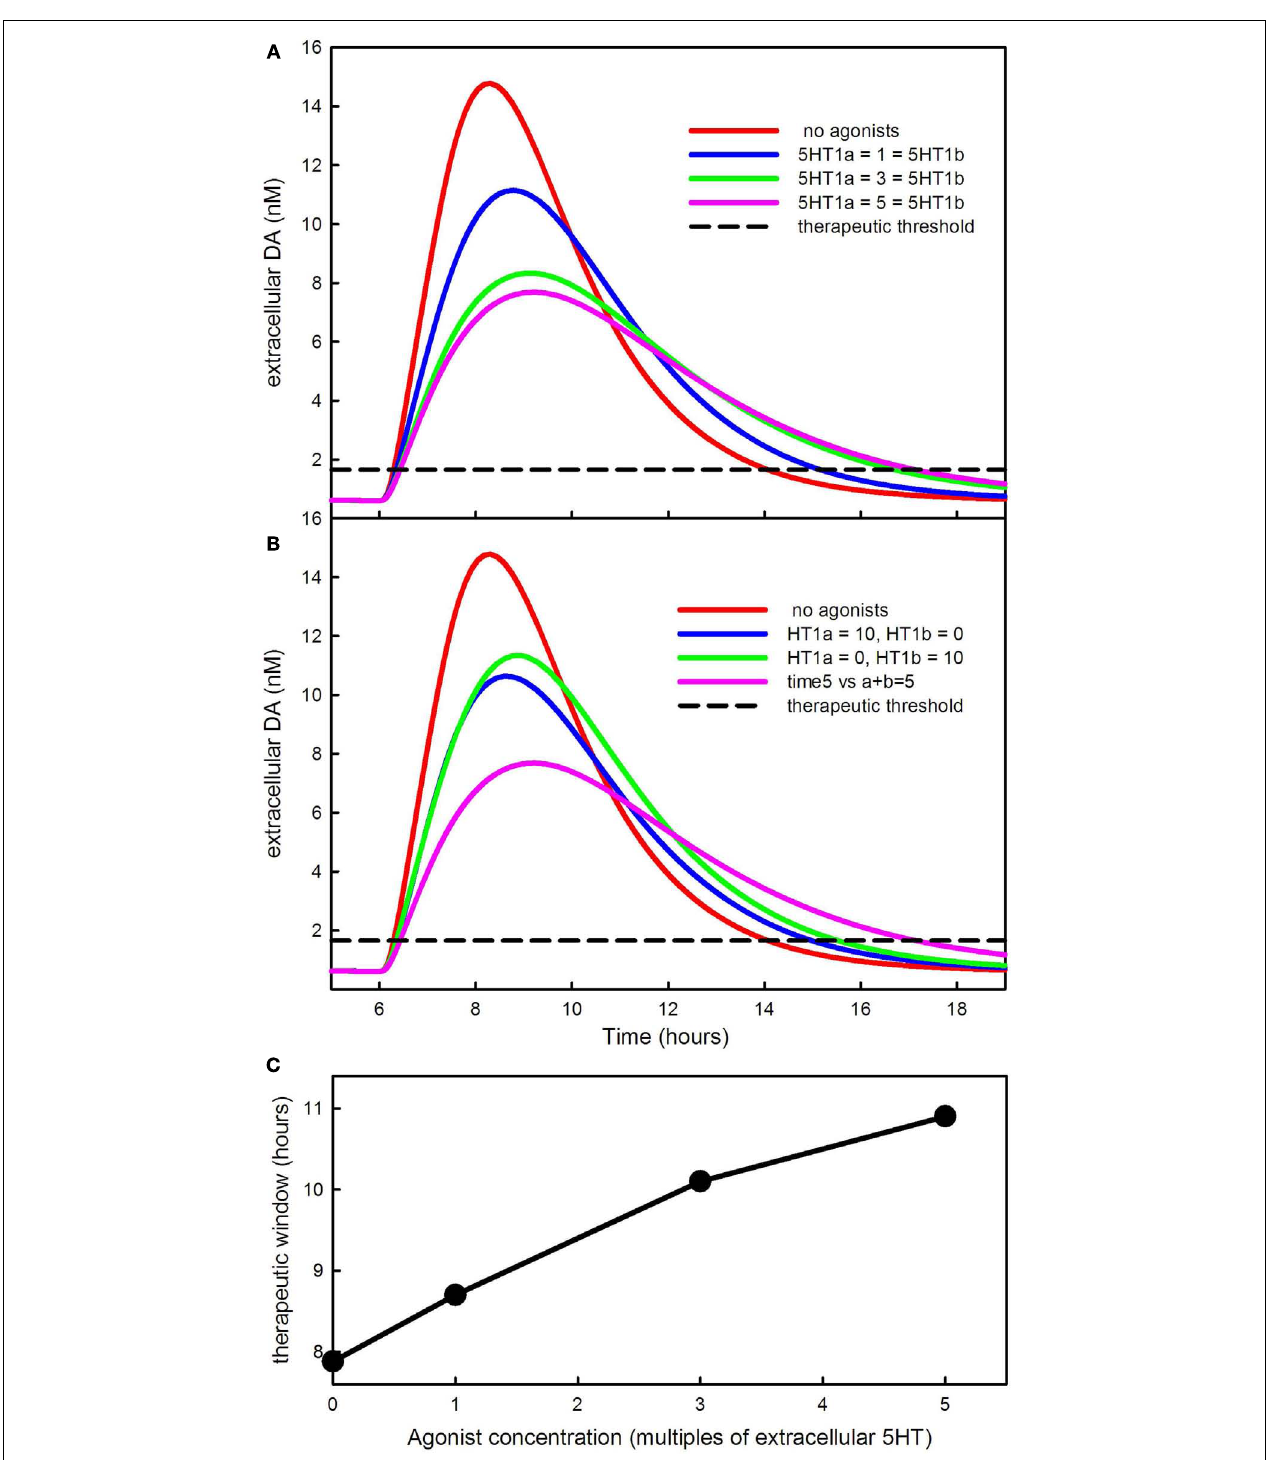
concentration. (B) Shows that the DA peak is lowered much more by dividing the dose between the agonists instead of giving either agonist alone. (C) Shows how much the therapeutic time window is increased by the